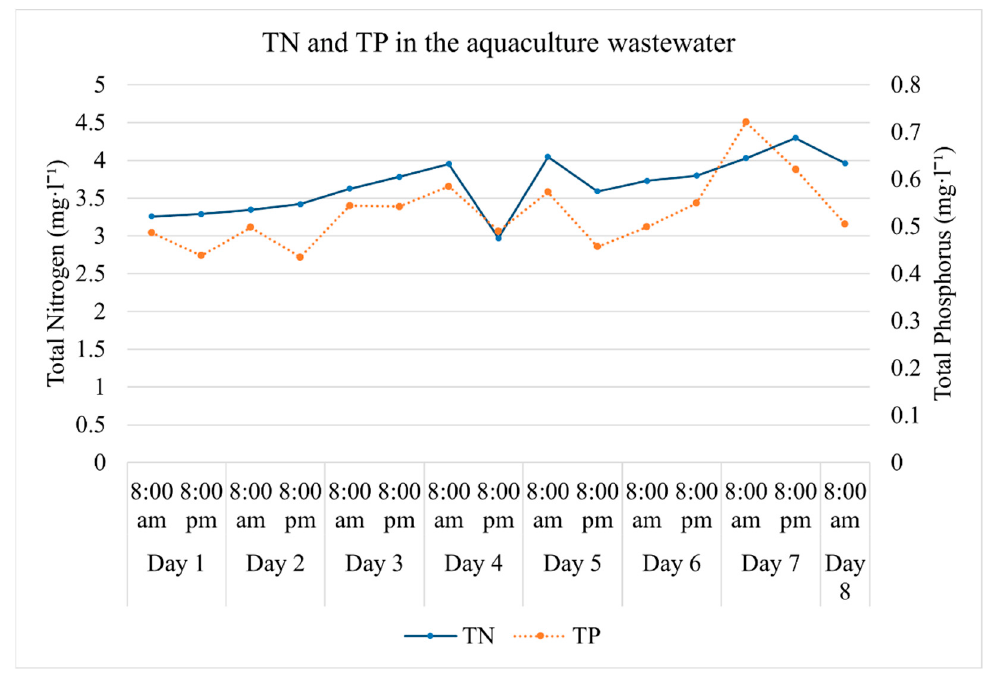
Figure 4. Total Nitrogen and Total Phosphorus concentrations in the aquaculture effluent measured at 8:00 am and 8:00 pm over the eight days of the experiment.